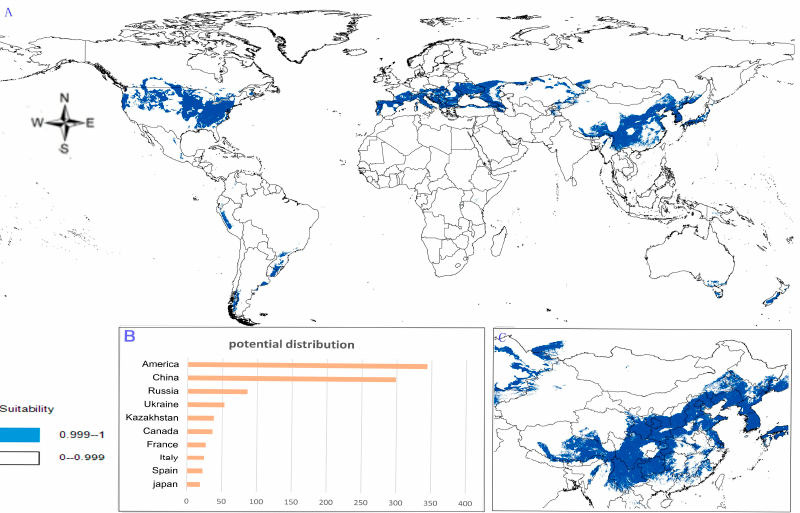
Figure 4. Spatial distribution map of potential suitable distribution for P. japonicus var. major by GMPGIS . ( A ) Global potential distribution; ( B ) Global rank of the potential distribution area; ( C ) Chinese potential distribution.